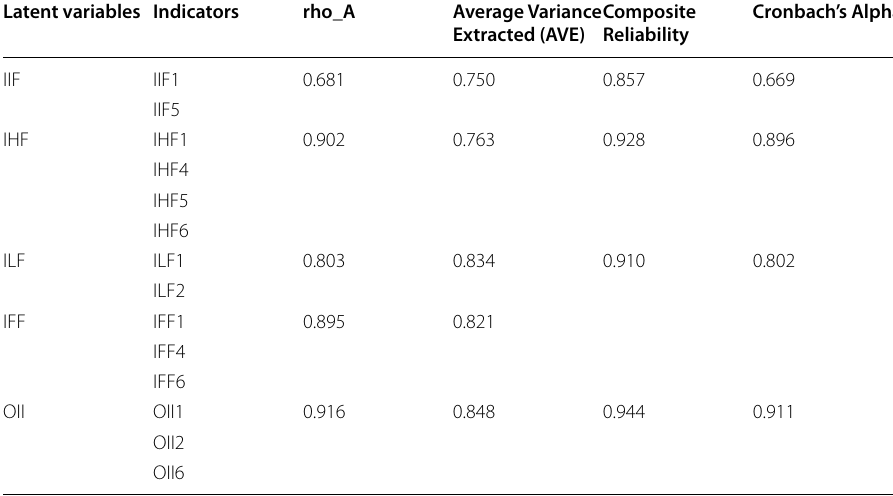
*Average Variance Extracted (AVE)